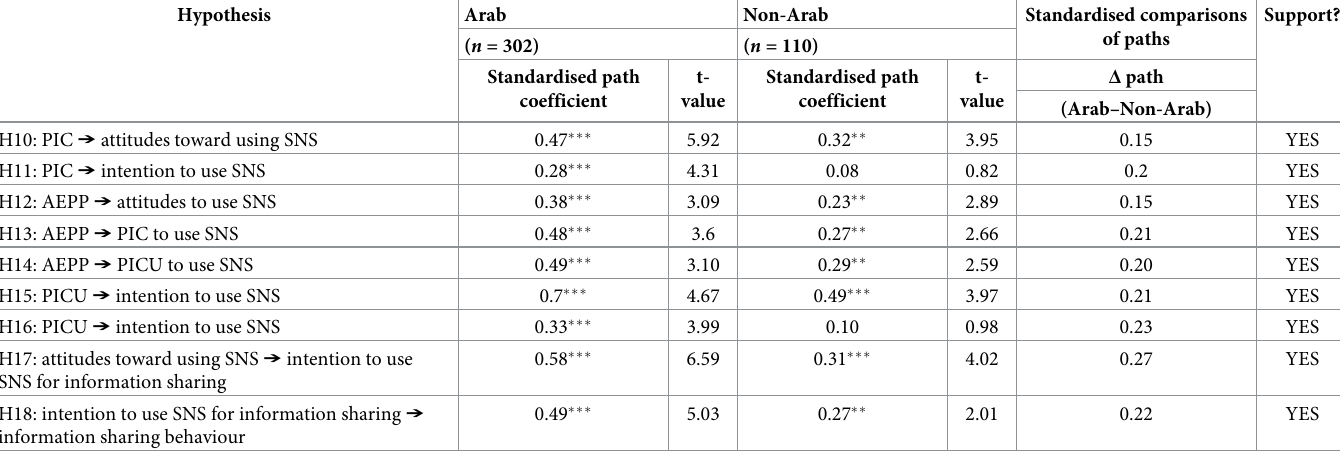
Table 7. Standardised comparisons of paths between Arab and non-Arab. Hypothesis Arab Non-Arab Standardised comparisons